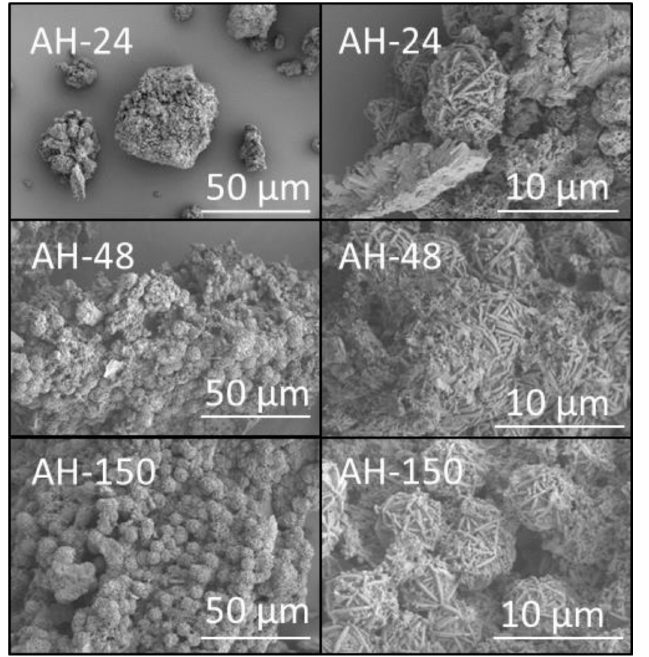
Figure 7. Secondary electron SEM images of hydrothermal products of amber container glass and amorphous aluminium hydroxide waste (AH) synthesised for 24, 48 and 150 h in 4.5 M NaOH (aq) at 100 ◦